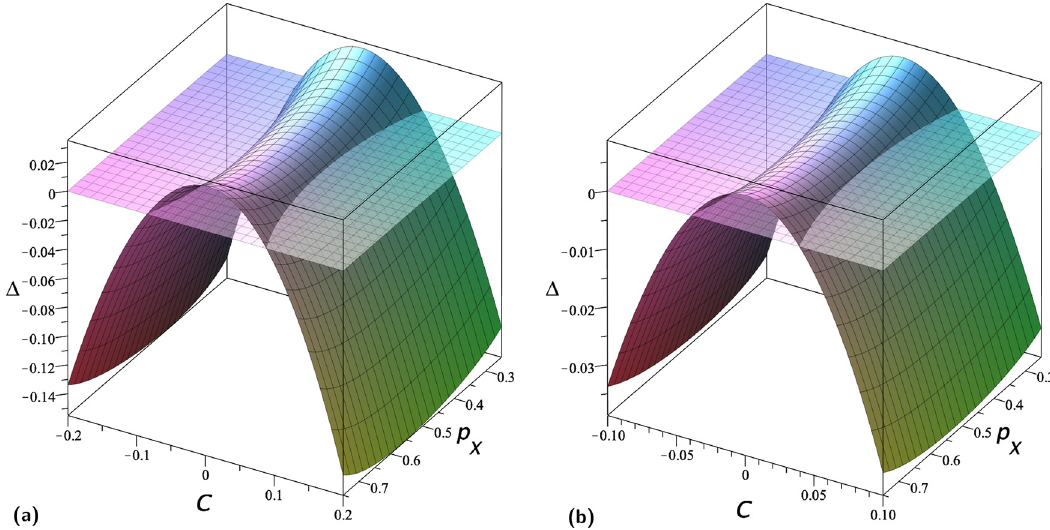
Figure 2: The relative di ff erence in variance of the two estimators for two sample sizes. ( a ) N 100 = and ( b ) N 400 =